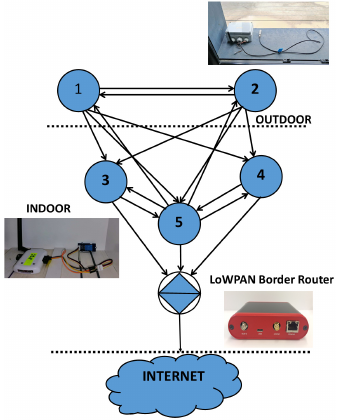
Figure 2. Network setup topology.